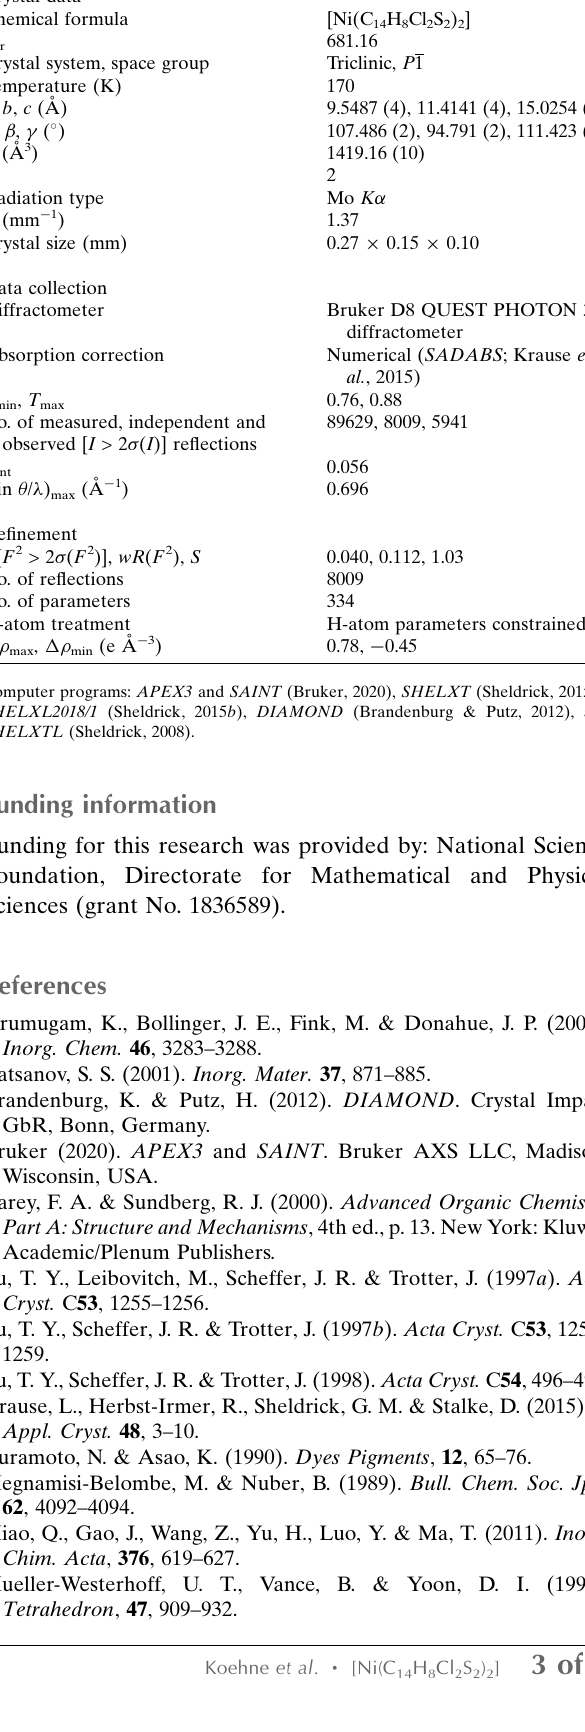
Table 1 Experimental details. Crystal data Chemical formula